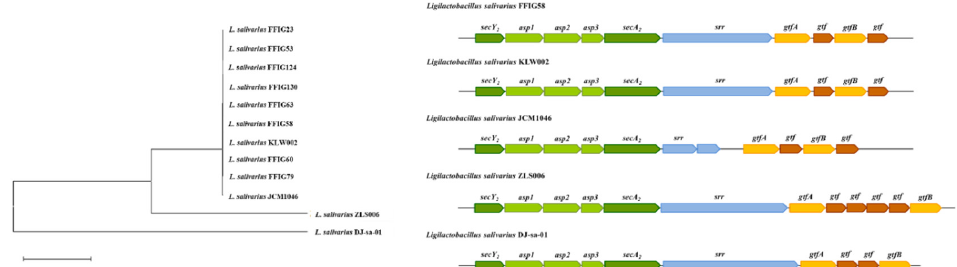
Figure 10. Genomic comparison of the SeA2-SecY2 accessory secretion system from Ligilactobacillus salivarius strains isolated from the intestinal mucosa of wakame-fed pigs and probiotic L. salivarius strains isolated from the intestinal tract of pigs, and chickens. The phylogenetic tree was constructed by using the sequences of the srr genes belonging to the SeA2-SecY2 cluster. Gene organization within the SeA2-SecY2 accessory secretion system for selected strains is shown. Conserved glycosyltransferases are shown in yellow, while non-conserved glycosyltransferases are shown in